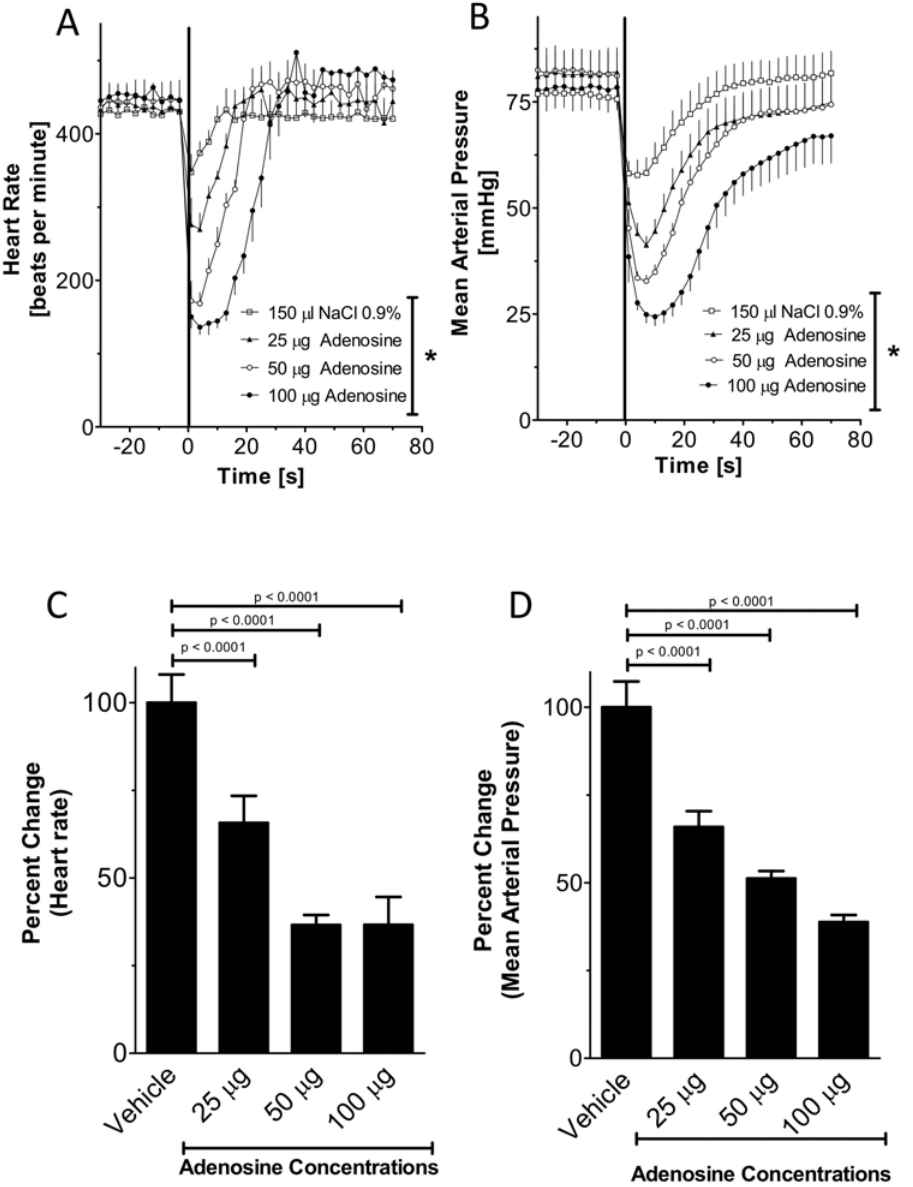
Figure 2. Changes of blood pressure andheart-rate followingvascular adenosine injection. Following insertion of a catheter into the common carotid artery, mean arterial blood pressure and heart rate were measured. Intravascular bolus injection of adenosine as indicated. (A, B) Wild type mice received vehicle (normal saline) or adenosineat indicated doses (100 m l). (C, D)Relative change in meanarterial bloodpressure or heart-rate. (A, B : * p , 0.05; n=8; mean 6 SEM).